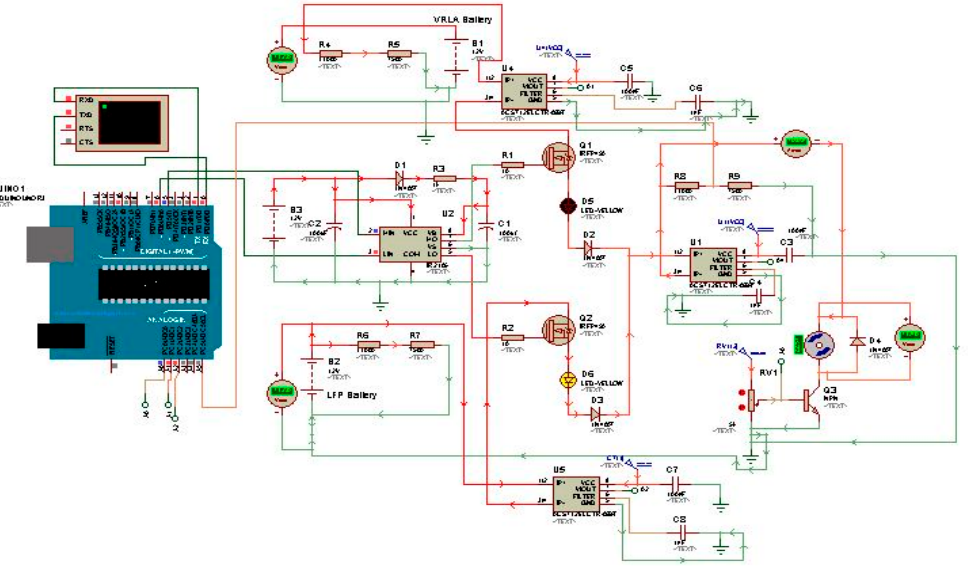
Figure 9. Simulation circuit run with potentiometer value of 60%. Switching wave testing is carried out to test whether the circuit is working or not. Testing of the switching wave on MOSFET is taken from the virtual oscilloscope. When switching occurs, the PWM value of the high output connected to the MOSFET gate will change from 255 to 0, produce in a soft-switching wave. The result of the switching wave on MOSFET connected to the LFP battery when the PWM value is 60% is depicted in Figure 10.